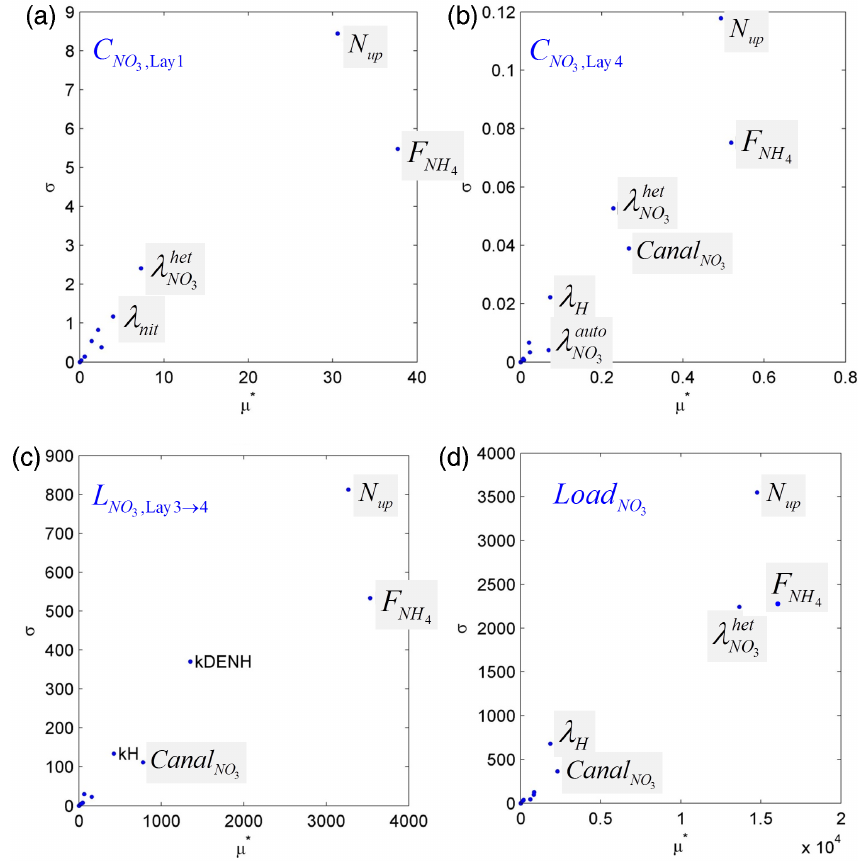
Figure 8. Global sensitivity plots ( σ vs. µ ∗ ) showing influence of the nine targeted model input factors on (a) C NO (top 0.5m of the root zone), (b) C NO in layer 4 of the model (shallow saturated zone of the aquifer), (c) NO 3 mass leaching from layer 3 to 3 layer 4 (unsaturated zone to saturated zone), and (d) total mass loading of NO 3 from the aquifer to the Arkansas